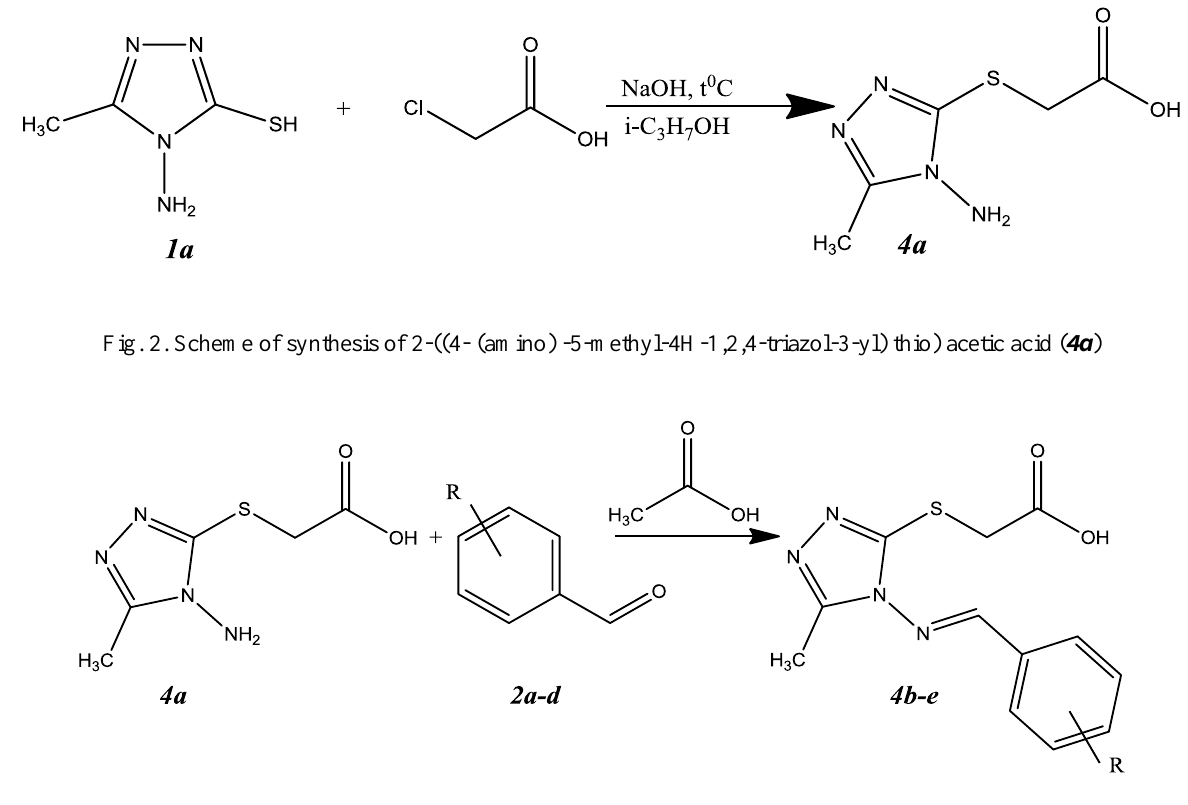
Compound ( 4c ) was obtained by counter-synthesis (Fig. 4). To 0.01 mole of 4- (2-hydroxybenzylideneamino) -5-methyl-4H-1,2,4-triazole-3-thiol solution ( 3b ) pre- dissolved in 40 ml of i-propanol with the addition of an equivalent amount of sodium hydroxide, add 0.01 mol of 2-chloroacetic acid dissolved in 5 ml of purified water. Boil for 5 hours, after which a precipitate forms, which is filtered off. The compound obtained in various ways does not depress the melting point.